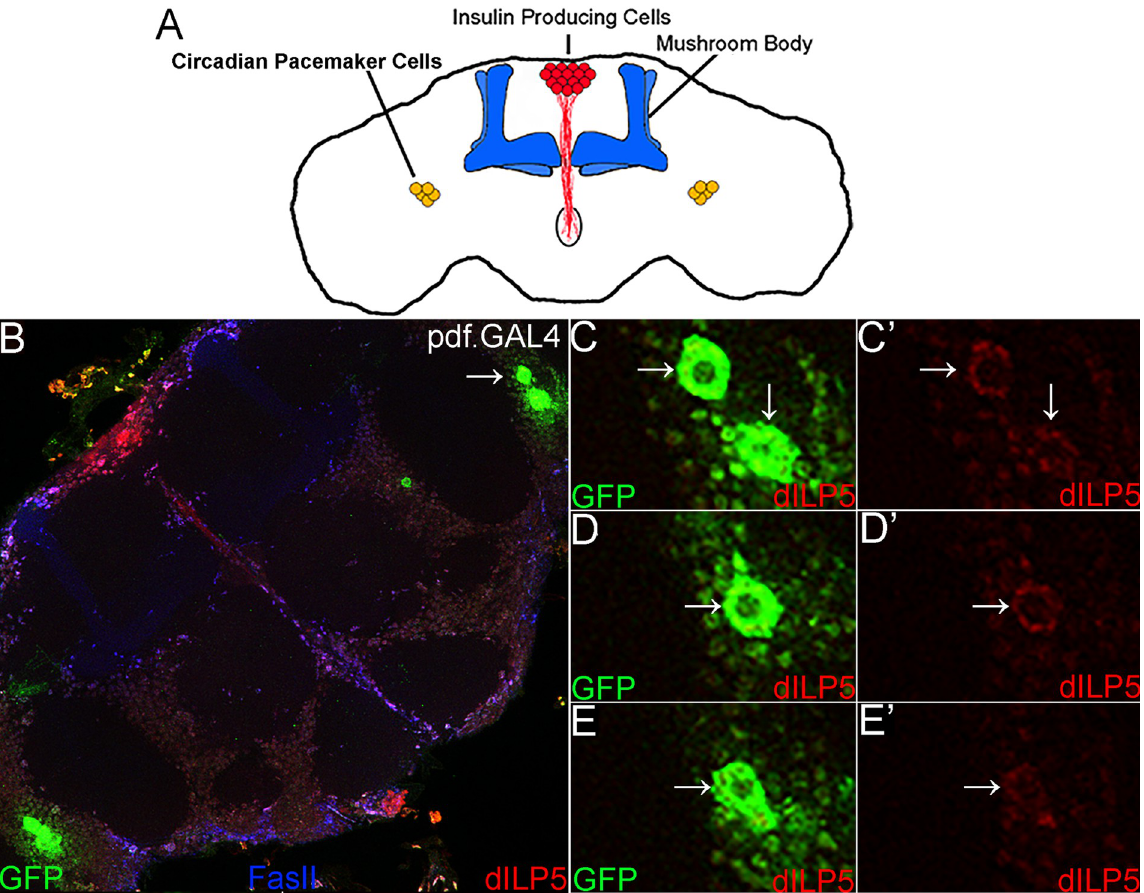
Fig 1. dILP5 is coexpressed with Pdf. GAL4 in circadian pacemaker cells. A) Illustration of a Drosophila adult brain in anterior view indicating clusters of insulin producing cells (IPCs; red express dILP2 and dILP5), circadian pacemaker cells (CPCs; yellow express dILP5), and the mushroom body (blue; for orientation). B-E) Brain in anterior view from a one day old unmated adult female with Pdf.GAL4 driven UAS. GFP. The secreted neuropeptide Pdf is a marker for small ventral Lateral Neurons sLNv also known as circadian pacemaker cells (CPCs; [18]). Pdf.GAL4 neurons express GFP (green) and dILP5 (red). B) Stack of CPCs (8 slices). Arrow indicates one of the two symmetrical clusters of CPCs that coexpress Pdf.GAL4 and dILP5. C-E) Single confocal slices of the indicated cluster. Two color images on the left and the red channel (dILP5) on the right. Slices together show that all four CPCs in the cluster coexpress Pdf.GAL4 and dILP5.